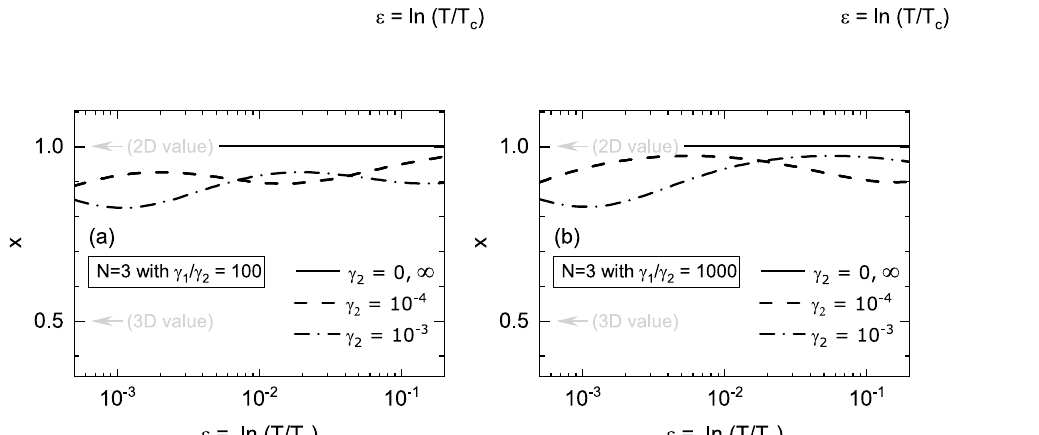
Fig. 10 Panel a Fluctuation specific heat c fl from our expressions for three-layer superconductors with dif- ferent Josephson couplings 𝛾 1 ∕ 𝛾 2 = 100 , as a function of the reduced temperature 𝜀 and for different values of 𝛾 2 . Panel b Same for an increased 𝛾 1 ∕ 𝛾 2 = 1000 . See also Figs. 11